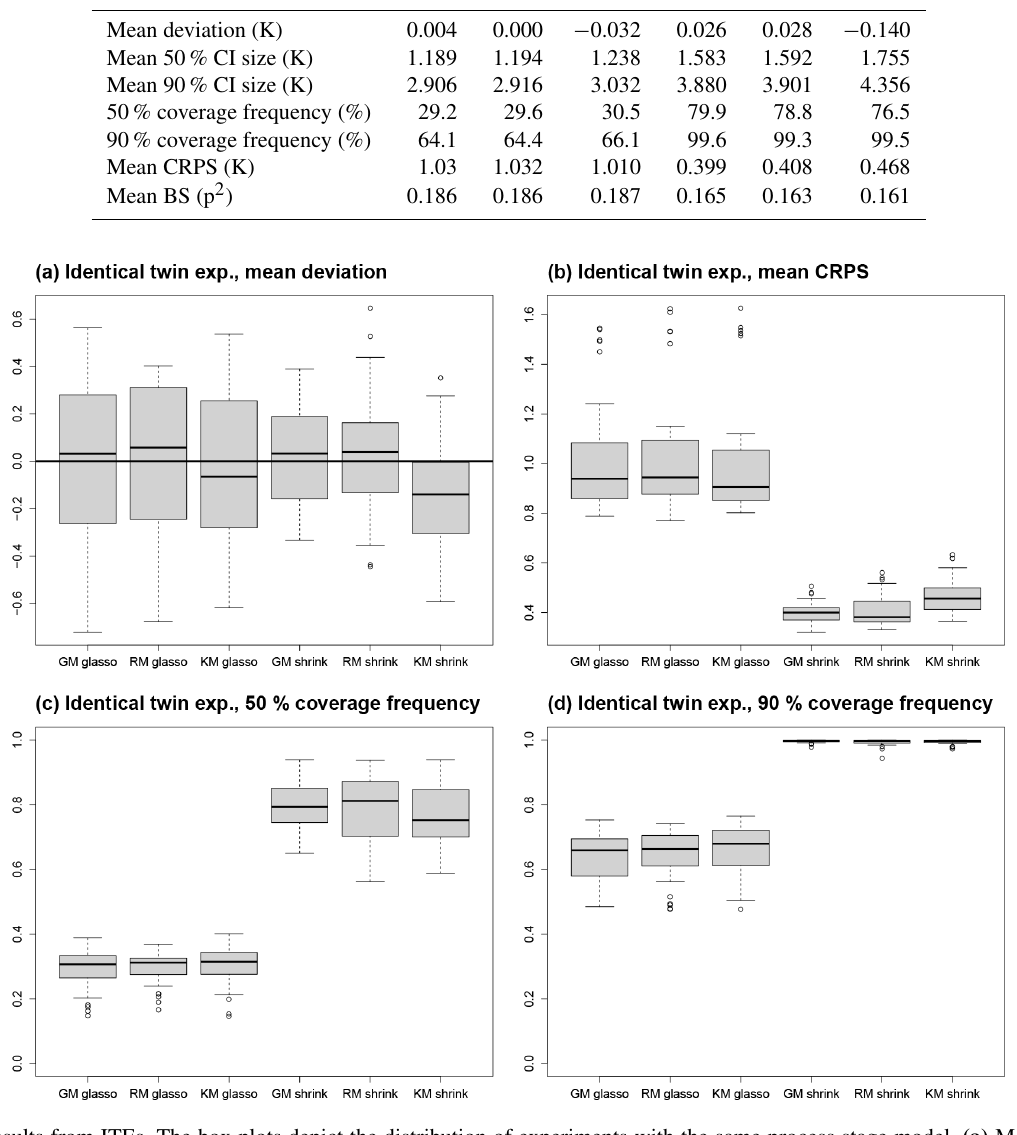
Figure 5. Results from ITEs. The box plots depict the distribution of experiments with the same process stage model. (a) Mean deviation from reference climate, (b) mean CRPS, (c) coverage frequency of 50% CIs, and (d) coverage frequency of 90%